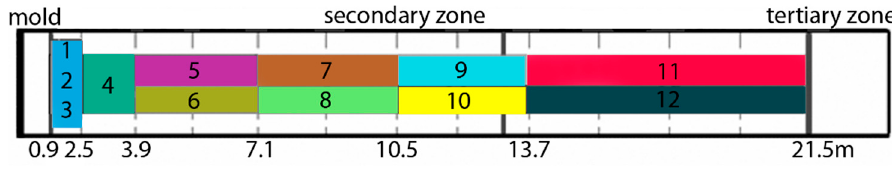
Figure 7. Position of cooling loops.